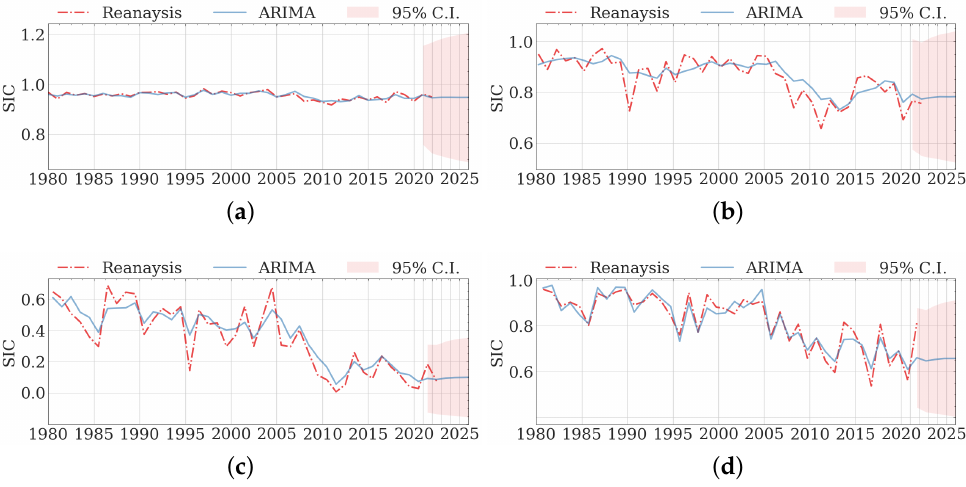
Figure 17. The quarterly means of reanalysis and forecast SICs in sub-region No. 2. ( a ) January, February, and March (JFM). ( b ) April, May, and June (AMJ). ( c ) July, August, and September (JAS). ( d ) October, November, and December